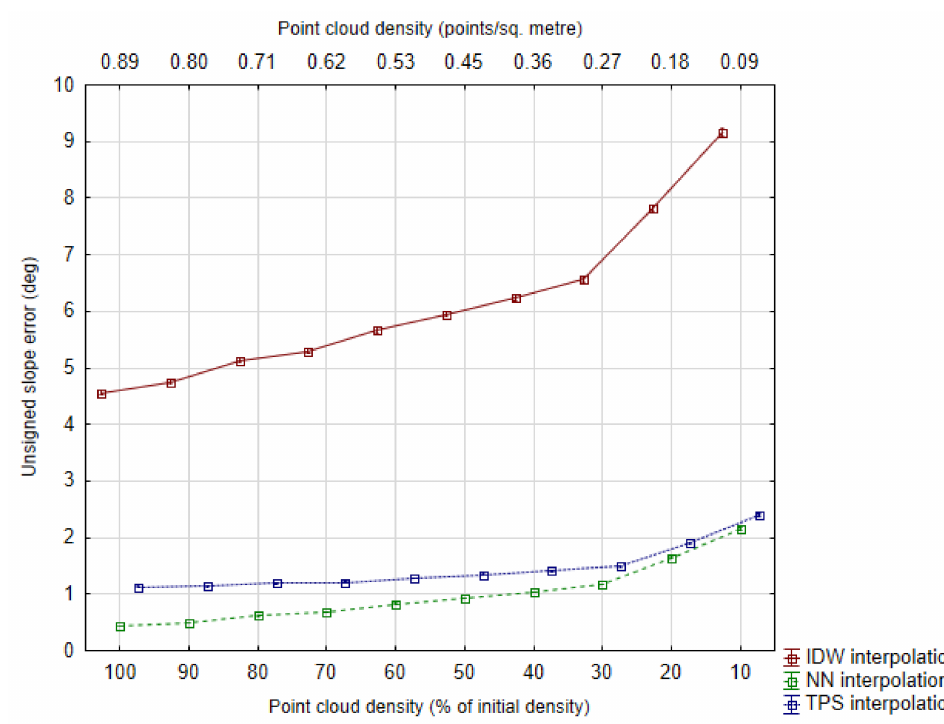
Figure 8. Mean unsigned elevation error as a measure of slope map accuracy, across different point densities. Whiskers represent the 95% confidence interval of mean values. Points are horizontally offset for